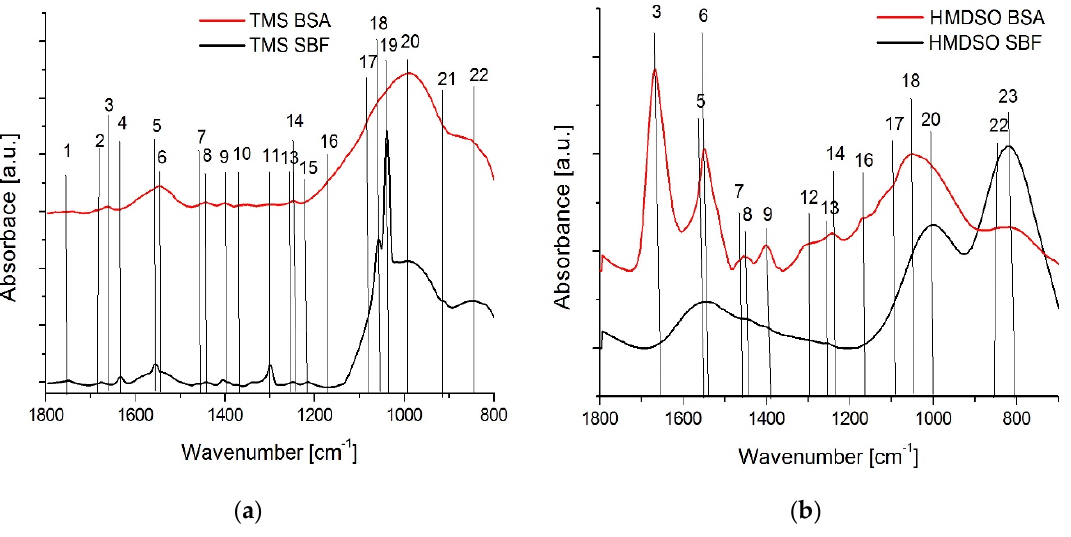
Figure 7. FTIR spectra of silicon-incorporated DLC coatings ( a ) deposited using TMS and ( b ) deposited using HMDSO, after ball-on-disc tests in SBF and BSA environments. Table 3. Characteristic IR absorption bands in the range of 1800–700 cm − 1 registered in the wear track of the analyzed silicon-incorporated DLC